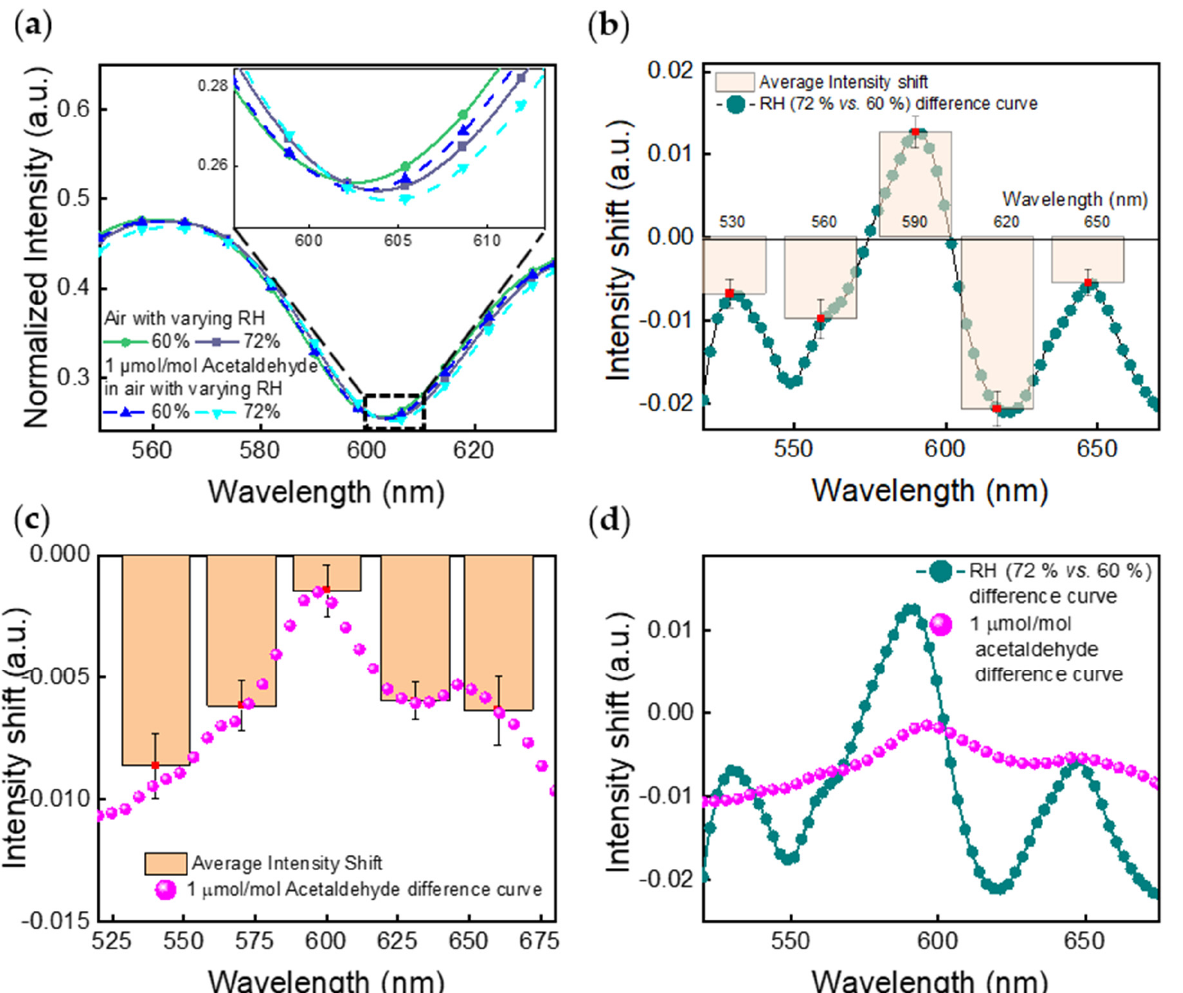
Figure 5. ( a ) Peak wavelength and intensity shifts of the NHA when exposed to air with 0 µmol/mol acetaldehyde and with 1 µmol/mol of acetaldehyde, both in backgrounds with 60% RH and 72% RH. ( b ) Response, shown as a difference curve, was obtained by subtracting the spectrum of the NHA in 60% RH air from the spectrum in 72% RH air. ( c ) Response, shown as a difference curve, was obtained by subtracting the spectrum of the NHA in 0 µmol/mol of acetaldehyde in air with 72% RH from the spectrum in 1 µmol/mol of acetaldehyde in air with 72% RH. Error bars along the y -axis represent ±1 standard deviation for measurement results captured in 3 different testing trials from 4 sensor chips. ( d ) Comparison of the difference curves generated for ( b , c ).